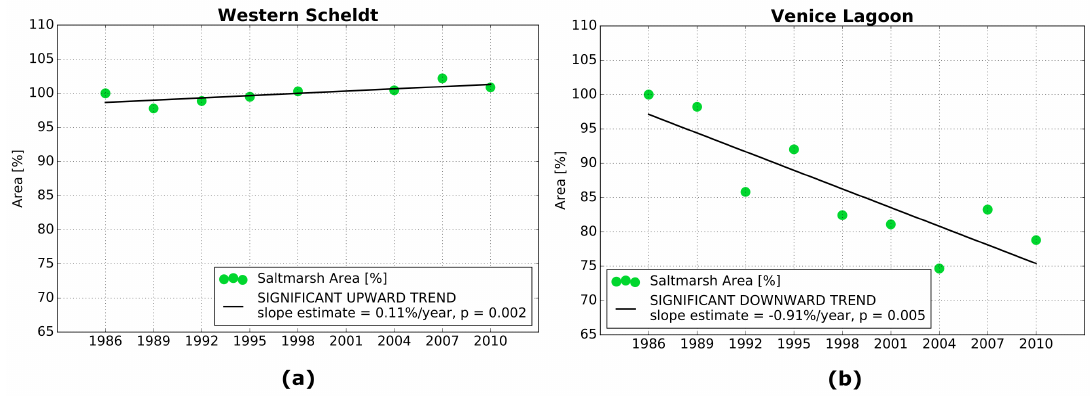
Figure 7. Time series of saltmarsh area (%) in the ( a ) Western Scheldt and ( b ) the Venice Lagoon. The straight lines show the linear fit of the data points and are derived by performing Mann–Kendall trend test with 0.05 level of significance.